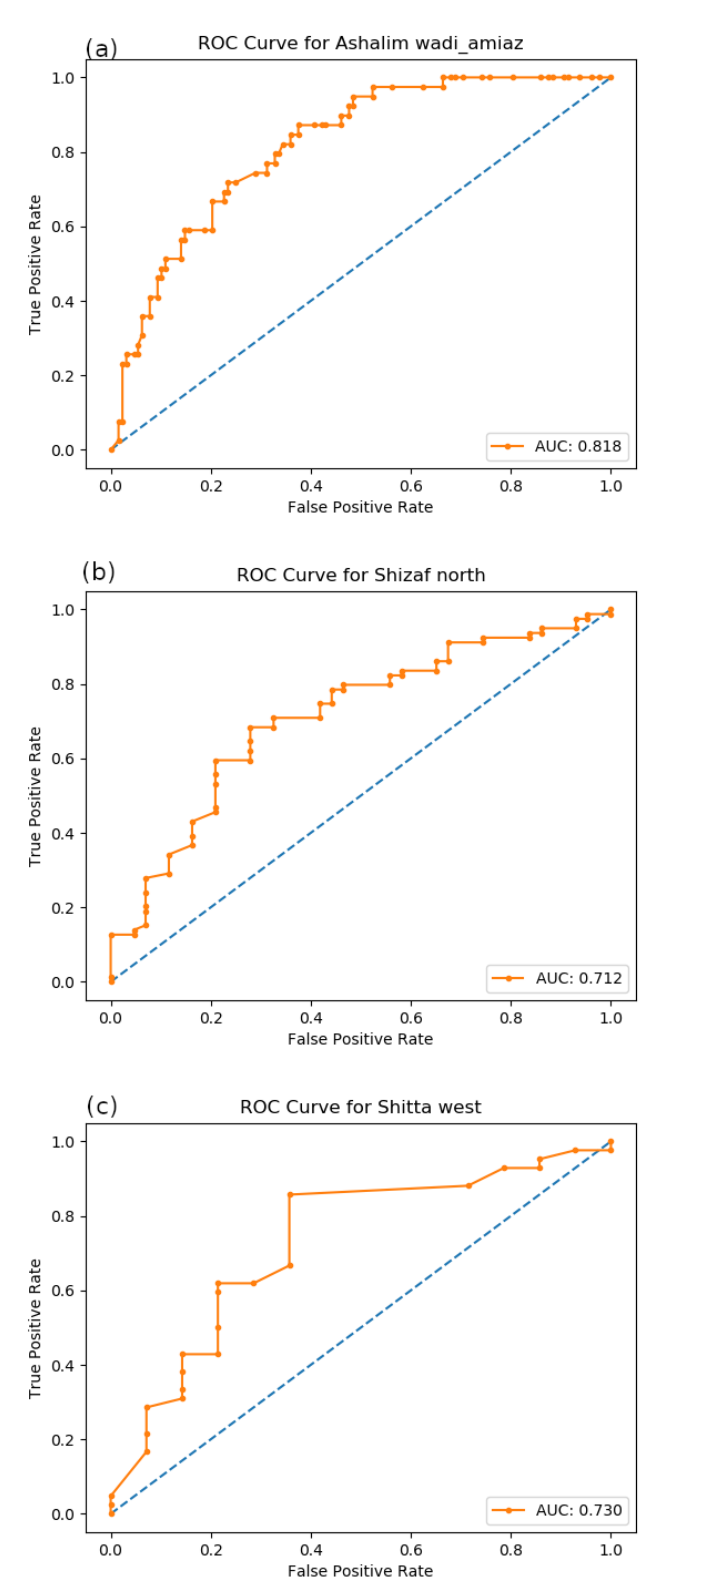
Figure 8. Three receiver operating characteristic (ROC) curves. Wadi Amiaz zone in Ashalim ( a ), northern zone in Shizaf ( b ), and the western zone in Shitta ( c